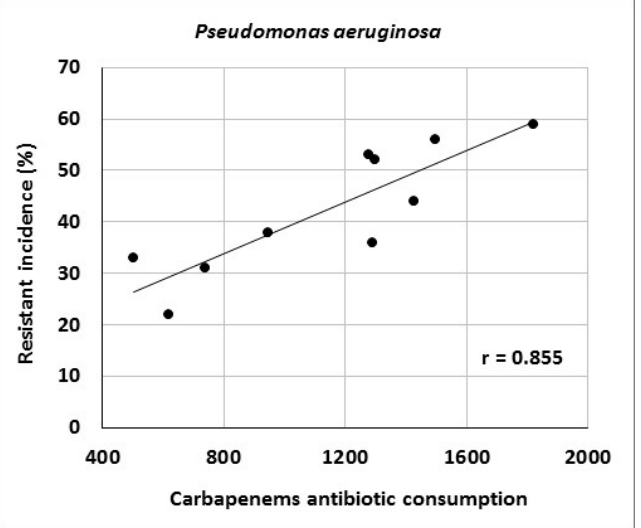
Figure 5. Correlation between carbapenem consumption (in numbers of defined daily doses) and resistance of Pseudomonas aeruginosa to meropenem. Table 12. Antibiotic consumption in defined daily doses (DDD) at the Department of Anesthesiology and Intensive Care Medicine .